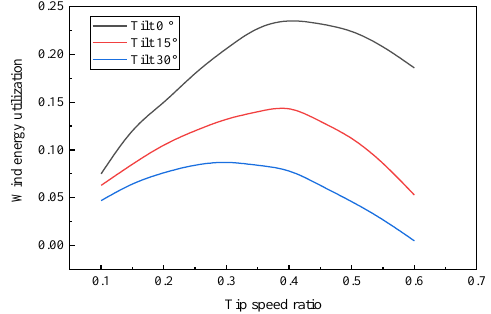
Figure 20. Comparison results of wind energy utilization at different deflecting angles.